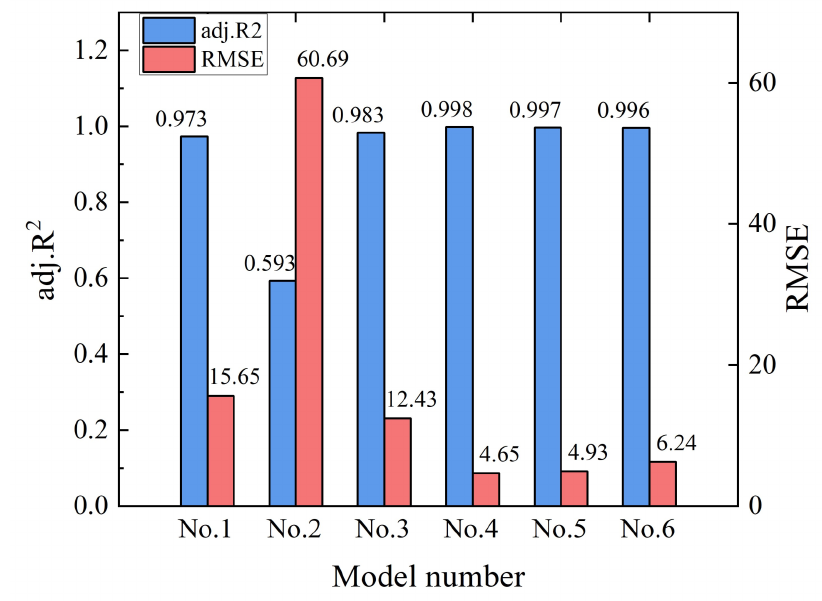
Figure 14. Goodness-of-fit index values of different resilient modulus prediction models for the gradation with G/S =